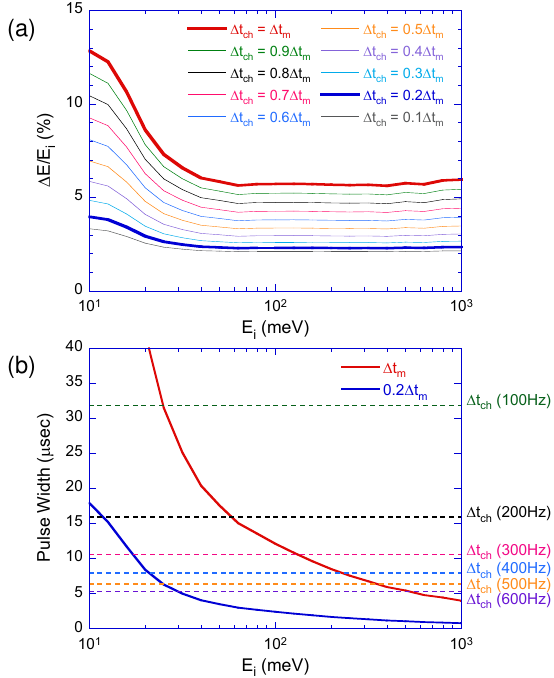
Figure 2. (a) Calculated energy resolutions as a function of E i when ∆ t ch varies from ∆ t m to 0 . 1 ∆ t m . The cases of ∆ t ch =∆ t m and 0 . 2 ∆ t m are indicated by thick lines. The sample size is 20mm in diameter. (b) The moderator pulse width of BL01 ∆ t m and 0 . 2 ∆ t m as a function of E i . Broken lines indicate the chopper pulse width for the 4SEASONS Fermi chopper rotated at 100–600 Hz.